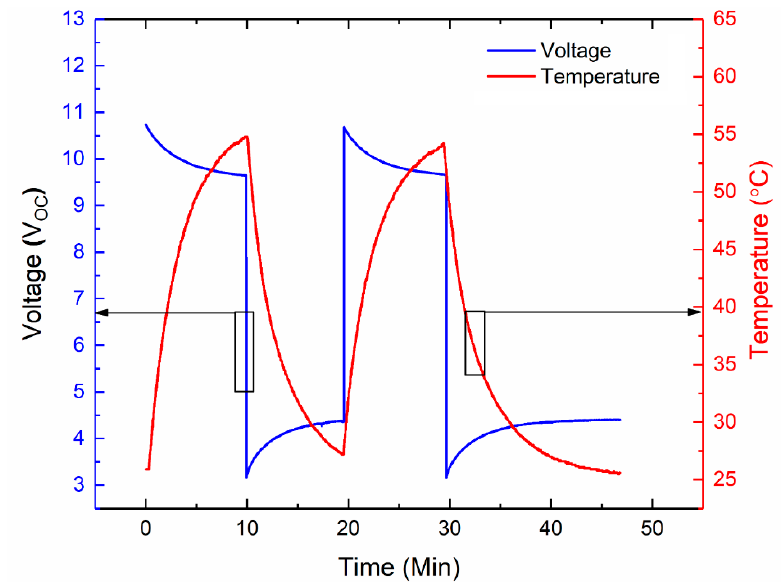
Figure 5. Open-circuit voltage and the cell temperature as the functions of time for the multi-junction solar cell under one sun illumination. The increase in the cell temperature under illumination results in the corresponding decrease in the open-circuit voltage.